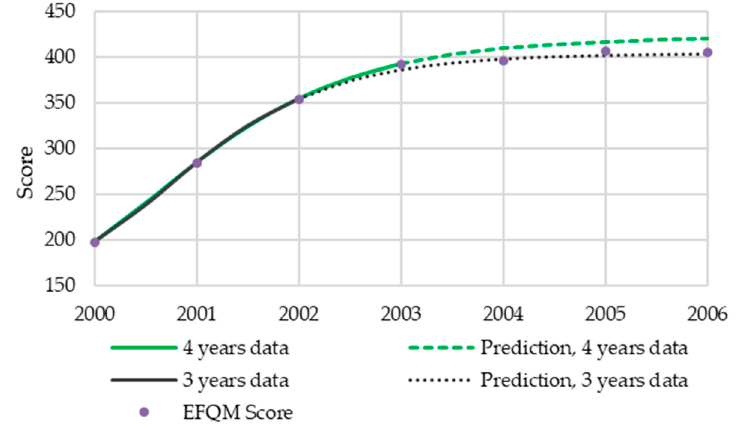
Figure 2. Level of Excellence forecasting using data from three and four years.